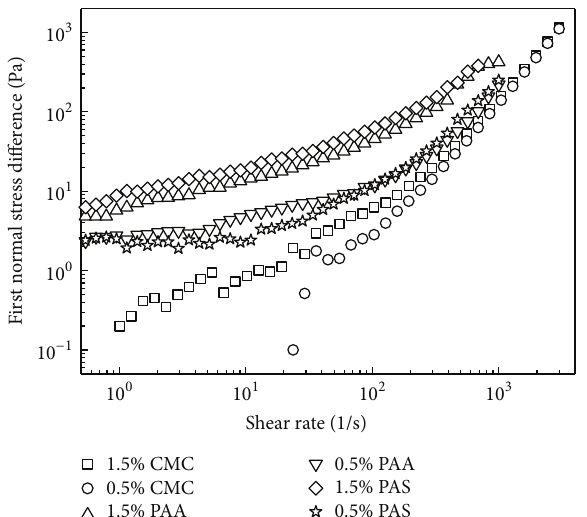
Figure 6: Position of bubble front corresponds to the velocity of bubble for 1.5 wt% CMC with gas flow 600 mL/min.